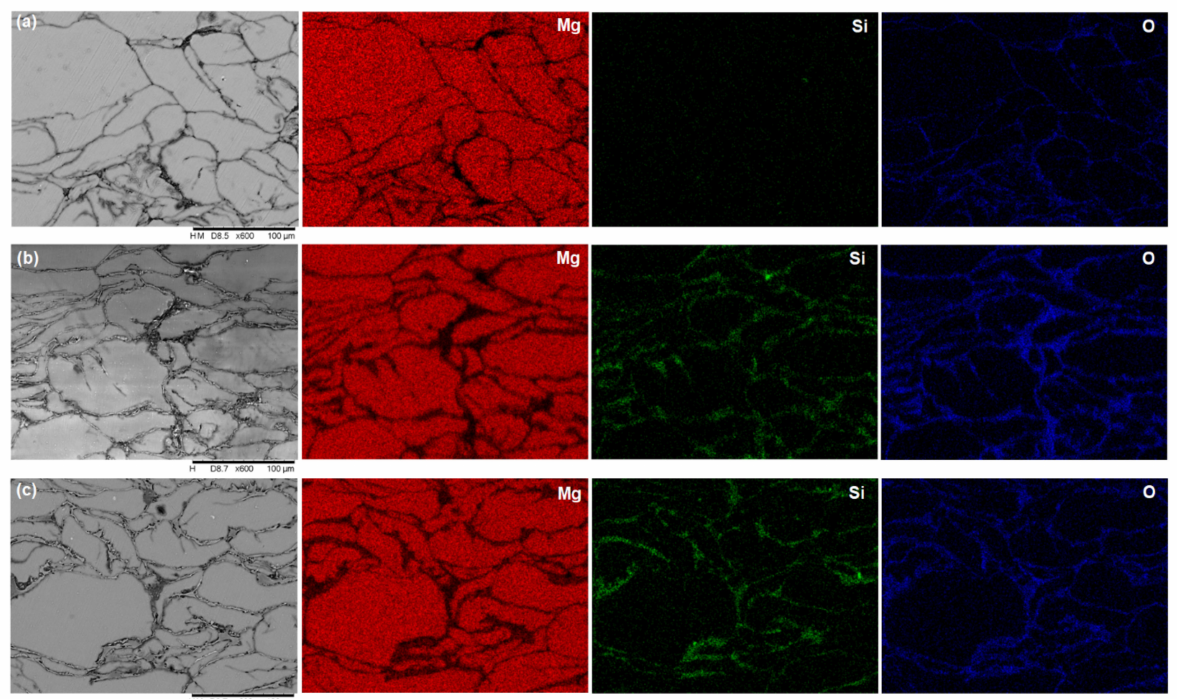
Figure 4. SEM micrograph and EDX elemental mapping of ( a ) Mg alloy, ( b ) Mg + 3% SiO 2 , ( c ) Mg + 5% SiO 2 .